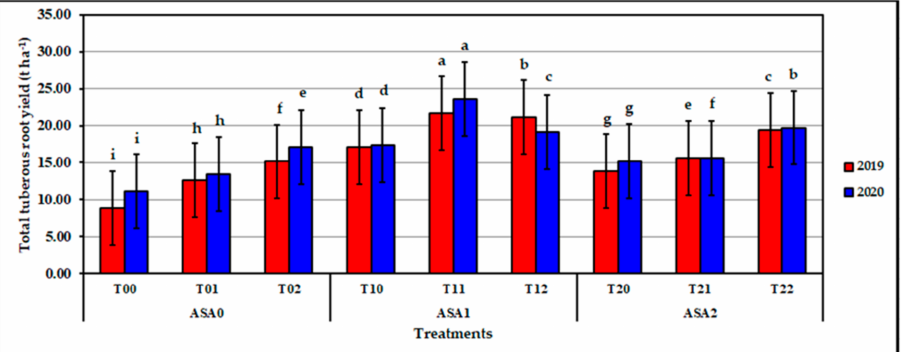
Figure 13. Influence of ascorbic acid doses on total tuberous roots yield of sweet potato in 2019 and 2020 seasons. Bars with a different letter indicate significant difference between treatments at p ≤ 0.05.